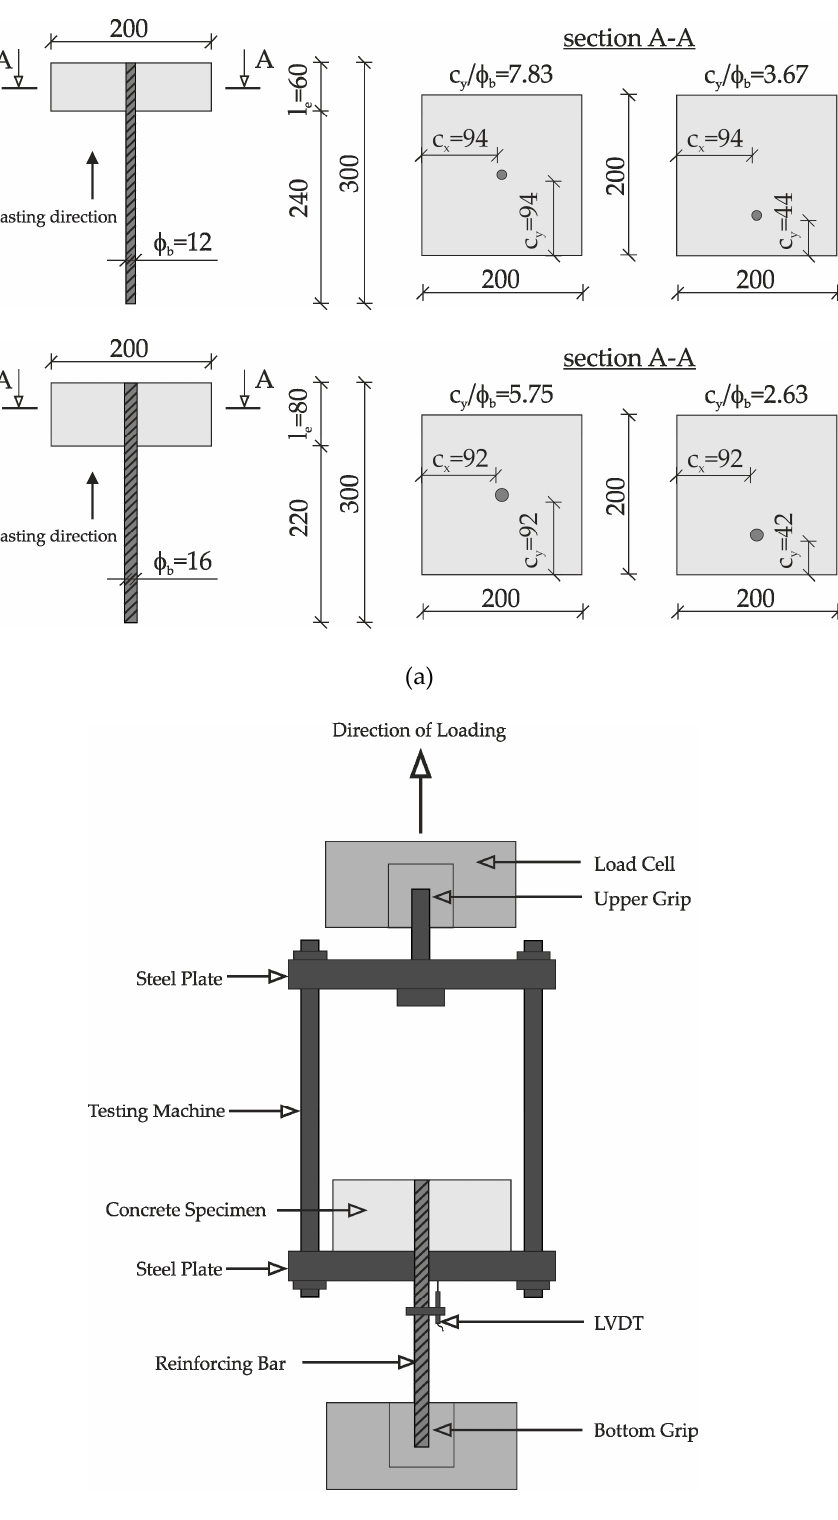
Figure 2. ( a ) Test specimen details (dimensions in mm), ( b ) test set-up.